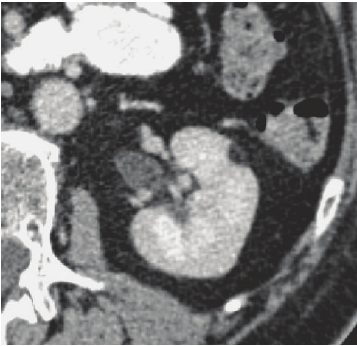
Figure 6: Angiomyolipoma. Contrast-enhanced CT shows a small homogeneous fat-containing mass.